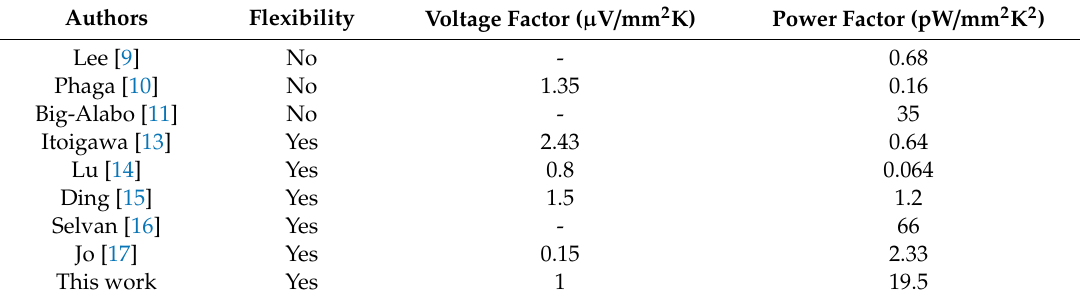
Table 1. Performances of various thermoelectric generators.